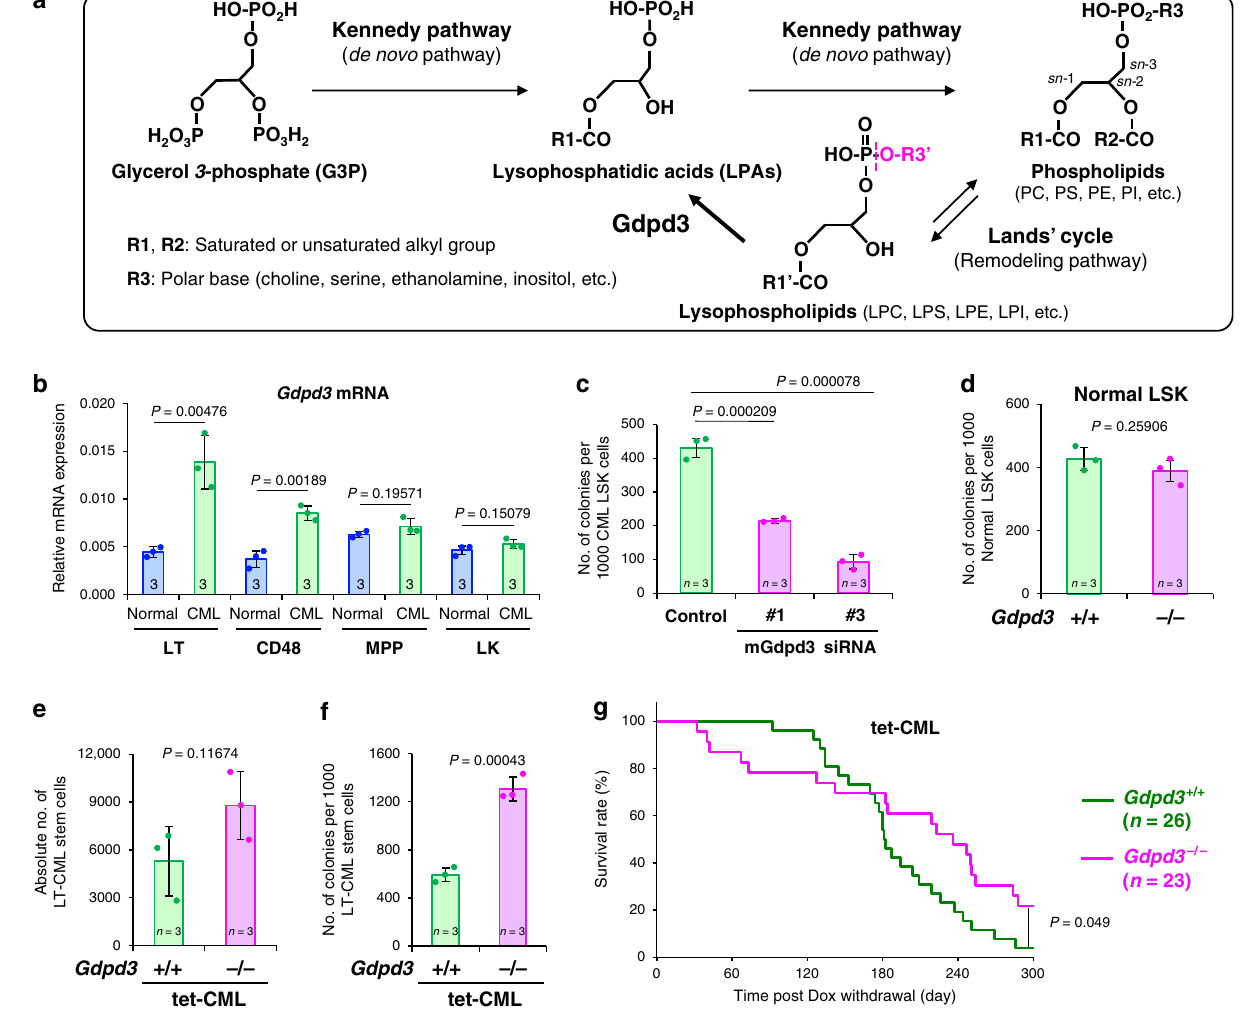
Fig. 1 Gdpd3 is implicated in CML disease initiation in vivo. a Diagram of pathways of lysophospholipid biosynthesis. G3P is converted into LPAs, and LPAs are then converted into phospholipids by the addition of polar bases via the Kennedy (de novo) pathway. The Lands ’ cycle (remodelling pathway) generates lysophospholipids of distinct composition by substituting fatty acid ester and polar base groups of phospholipids. Lysophospholipase D Gdpd3 converts lysophospholipids back into LPAs by catalysing hydrolysis (magenta dotted line). (PC Phosphatidylcholine, PS Phosphatidylserine, PE Phosphatidylethanolamine, PI Phosphatidylinositol, LPC Lysophosphatidylcholine, LPS Lysophosphatidylserine, LPE Lysophosphatidylethanolamine, LPI Lysophosphatidylinositol). b qRT-PCR determination of Gdpd3 mRNA expression in LT-stem (LT), CD48, MPP, and LK cells (see Supplementary Fig.2) isolated from Gdpd3 + / + tet-CML-affected (SCL-tTA + TRE-BCR-ABL1 + ) mice (one male, six females) or normal littermate (SCL-tTA + ) mice (four males, four females). Data are the mean ratio ± s.d. of transcript levels normalised to Actb ( n = 3 biologically independent samples) ( P -value, unpaired two-sided Student ’ s t -test). c Quantitation of the colony-forming capacity of Gdpd3 + / + CML-LSK cells that were transduced with/without Cy3-labelled siRNA targetting mouse Gdpd3 mRNA (mGdpd3 siRNA #1 or #3). Cy3 + and Cy3 − CML-LSK cells were puri fi ed at 3 days post-transduction and plated in semi- solid methylcellulose medium. Data are the mean colony number ± s.d. ( n = 3) and are representative of biologically independent three experiments ( P -value compared with control, unpaired two-sided Student ’ s t -test). d Quantitation of colony-forming capacity of haematopoietic stem/progenitor (LSK) cells that were isolated from normal Gdpd3 + / + (one female) and Gdpd3 − / − (one female) mouse and cultured in semi-solid methylcellulose medium under hypoxic (3% O 2 ) conditions. Data are the mean colony number±s.d. ( n = 3) and are representative of biologically independent two experiments ( P -value, (three females, n = 3 biologically independent samples) and Gdpd3 − / − tet-CML-affected mice (one male, two females, n = 3 biologically